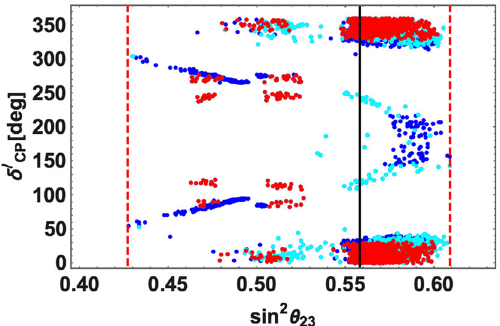
Fig. 7 Predicted δ (cid:4) versus sin 2 θ 23 , where the black line denotes CP observed best-fit value of sin 2 θ 23 , and red dashed-lines denote its upper(lower)-bound of 3 σ interval for NH. Colors of points correspond to points of τ in Fig. 4